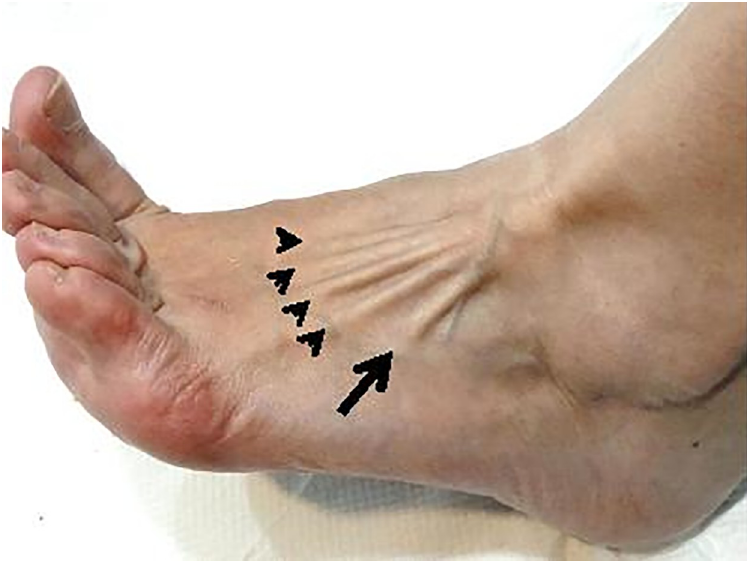
Fig 1. Dorsolateral view of left foot and ankle showing the tendons of the fibularis tertius (arrow) and the extensor digitorum longus tendons (arrowheads).